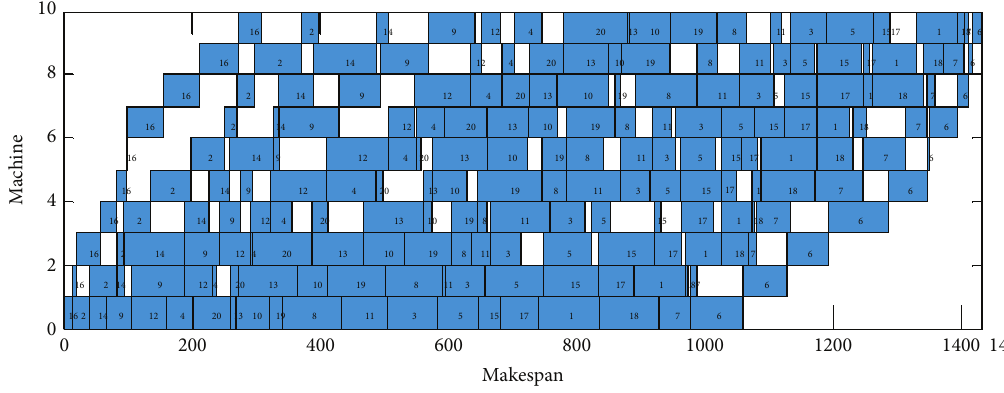
Figure 9: Gantt chart of an optimal schedule for Rec11, 𝜋 ∗ = [16, 2, 14, 9,12, 4, 20, 13, 10, 19, 8,11, 3, 5, 15, 17, 1,18, 7, 6] .